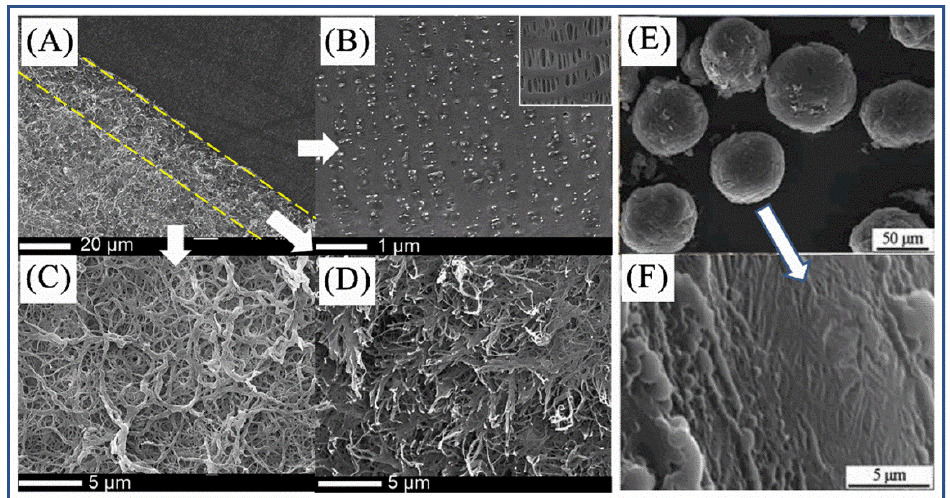
Figure 12. SEM images of PANF/polymer composites: ( A ) The vertical view of the entire PPTA@PPs separator. ( B ) PP substrate being peeled from the PPTA nanofiber coating layer. The inset is the original PP substrate. ( C ) Surface morphology of PPTA nanofiber coating layer. ( D ) Internal morphology of the PPTA nanofiber coating layer [80]. Copyright 2018 John Wiley and Sons. ( E ) SEM image of the PANF@PS composite microspheres. ( F ) The PANFs on the surfaces of the PANF@PS composite microspheres [81]. Copyright 2017 American Chemical Society.